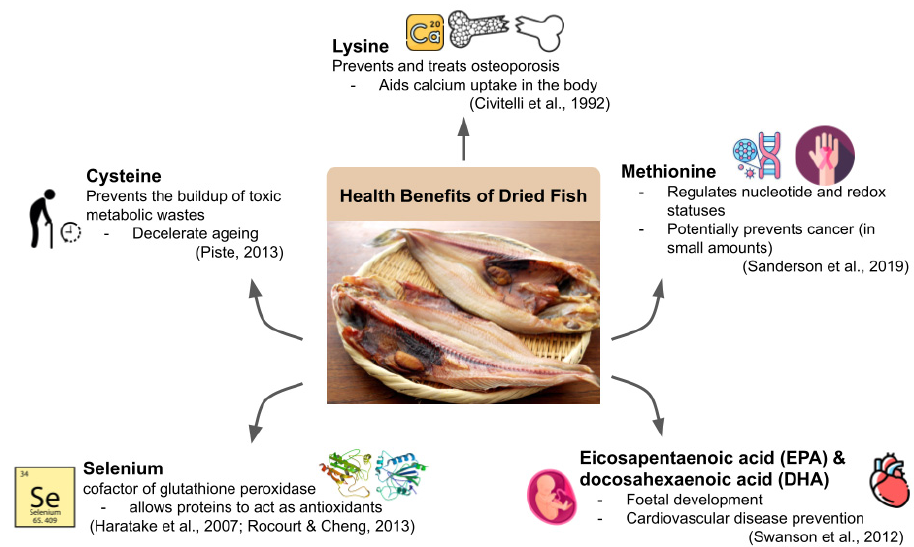
Figure 2. Summary of health benefits of dried fish constituents such as lysine [28], methionine [27], EPA and DHA [29], selenium [30,31], and cysteine [26,28]